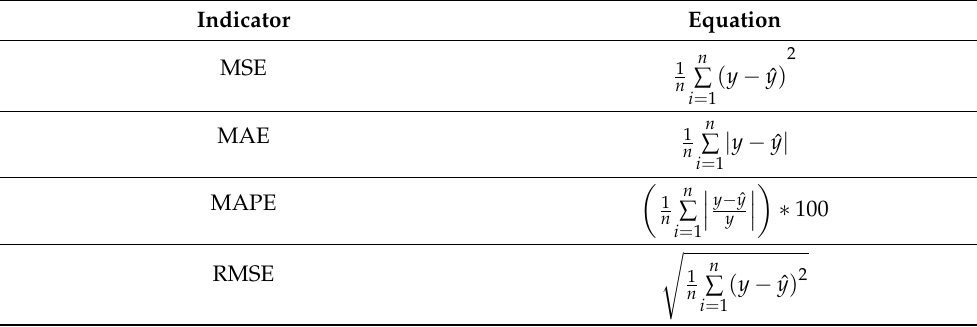
Table 3. Performance metrics used to evaluate forecasting models.